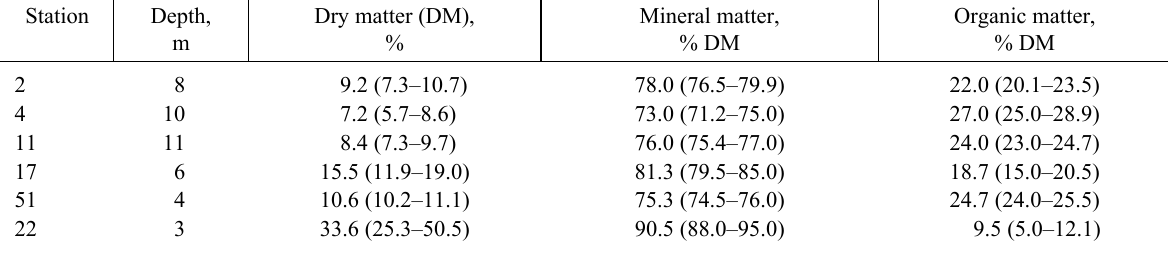
Table 1. Water depth, the average and the range values of sediment characteristics at the sampling stations during 2004(cid:150)2009 Station